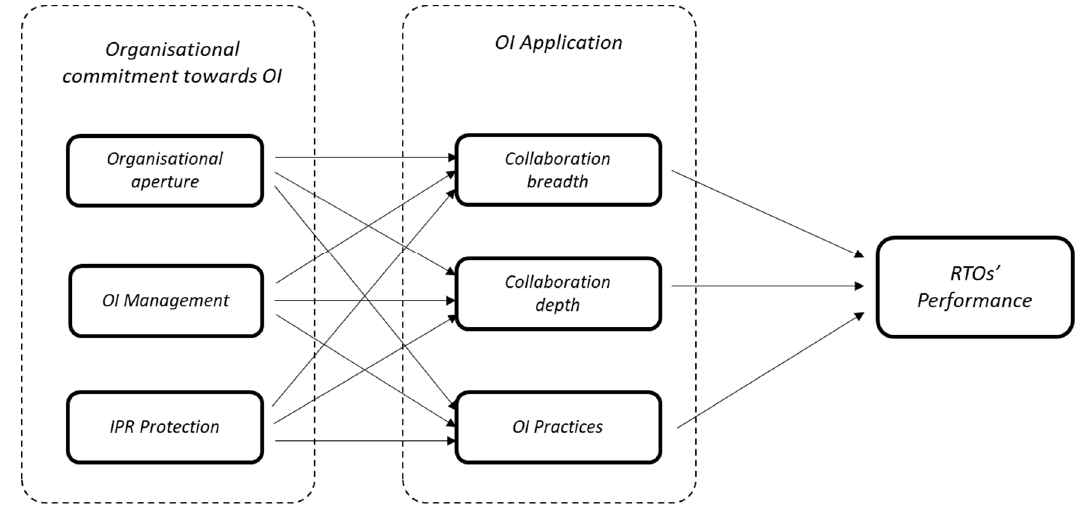
Figure 1. Research model.